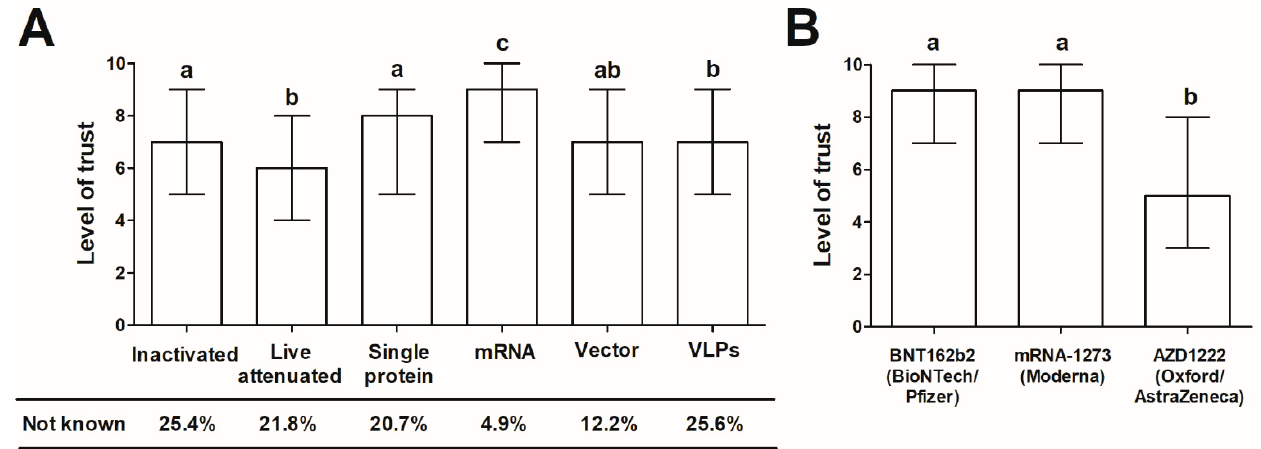
Figure 1. ( A ) The general level of trust (evaluated using 10-point Likert-type scale) in vaccines in relation to their technology and ( B ) trust in COVID-19 vaccines already approved and in use in Poland. The data is presented as the median and interquartile range. Different letters indicate statistically significant differences between vaccines (all p < 0.001, except ( A ) single protein vs. vector vaccine, for which p = 0.0013) demonstrated with the post-hoc Dunn’s test following the Kruskal-Wallis ANOVA ( p < 0.001 for ( A , B ) comparisons).